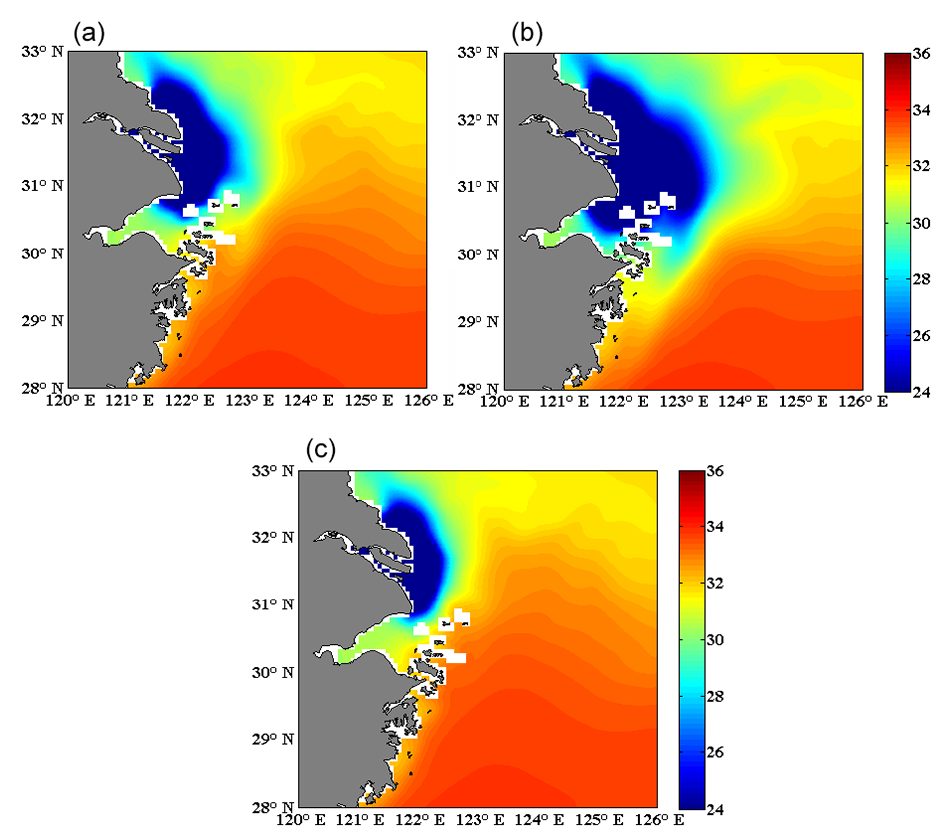
Figure 12. Averaged surface salinity for the period July to September in 2010 for the river runs. (a–c) The base run, Q 2 , and Q 0 . 5 , respec-